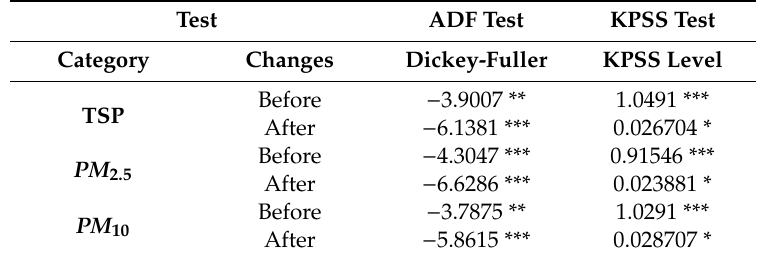
Table 3. The stationarity process of metal and sand throughput PM concentration data.